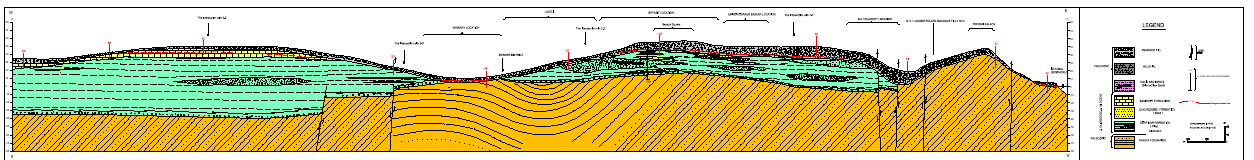
Zeytinburnu in the east. The bedrock surfaces just